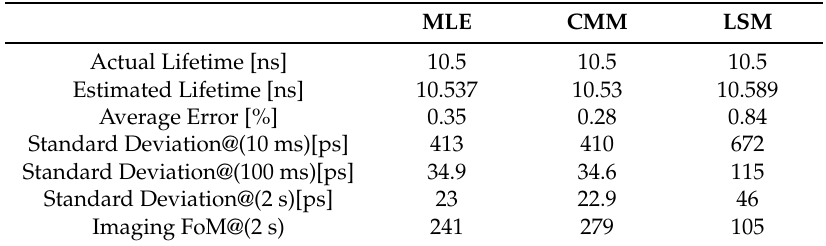
Table 1. The simulation results of lifetimes of 10.5 ns.